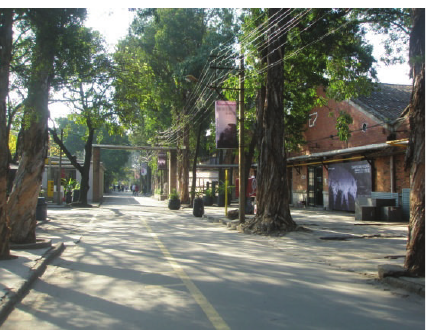
Figure 15: A view of